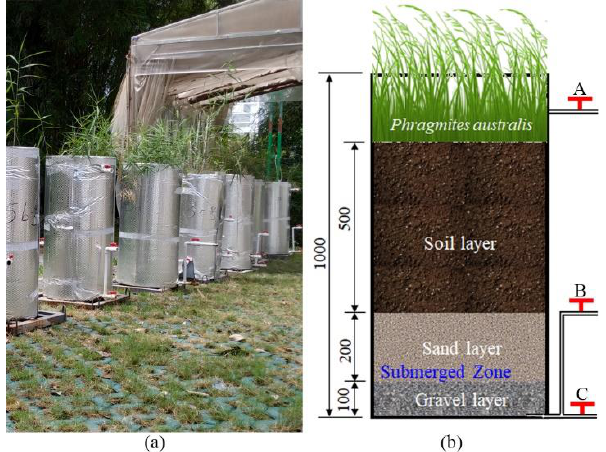
Figure 1. Bioretention columns: photo of the experimental site ( a ) and structure diagram of experimental columns (unit: mm) ( b ).